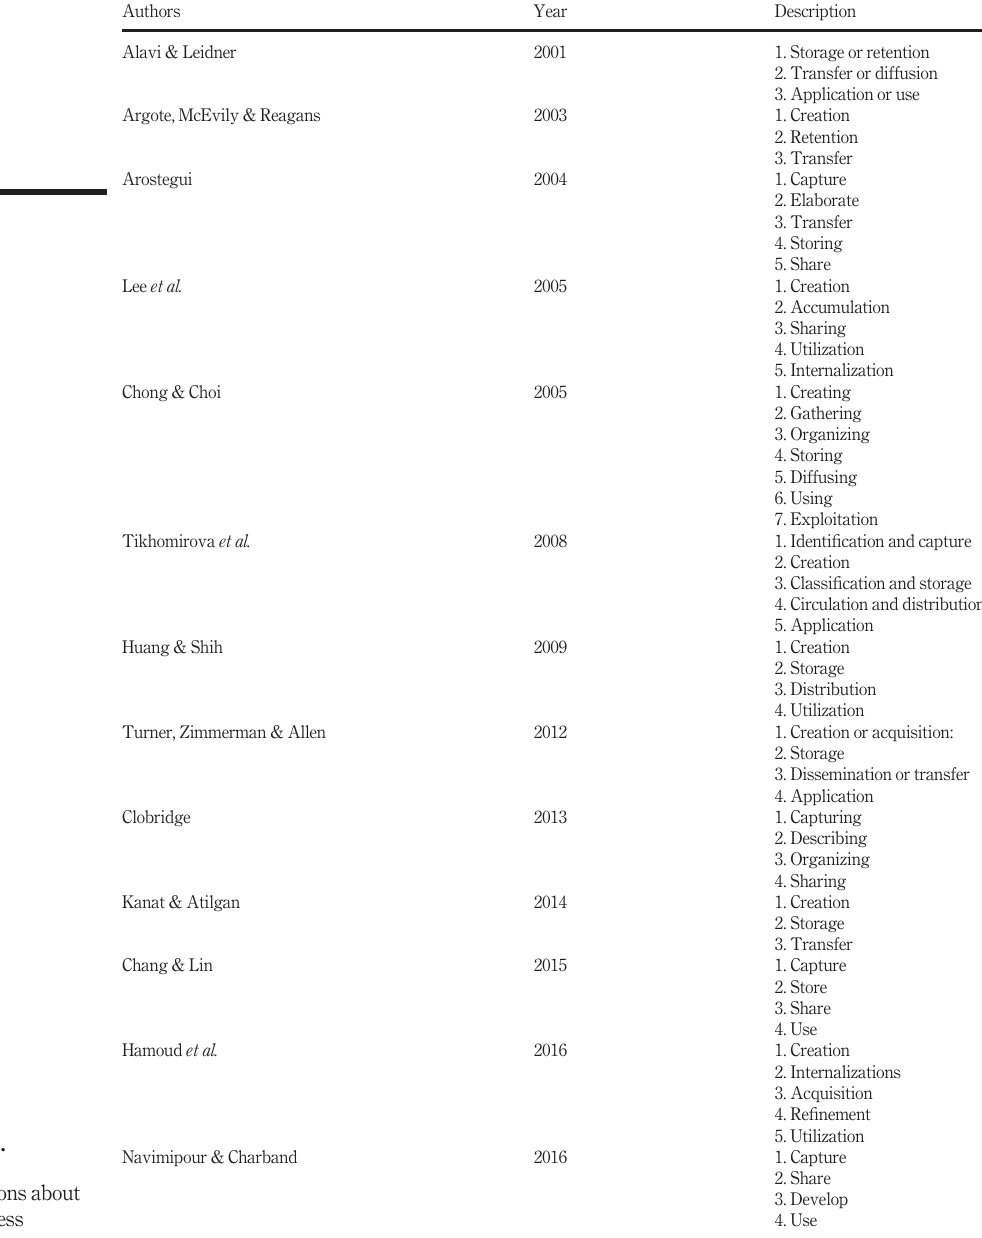
Table II. Different descriptions about KM